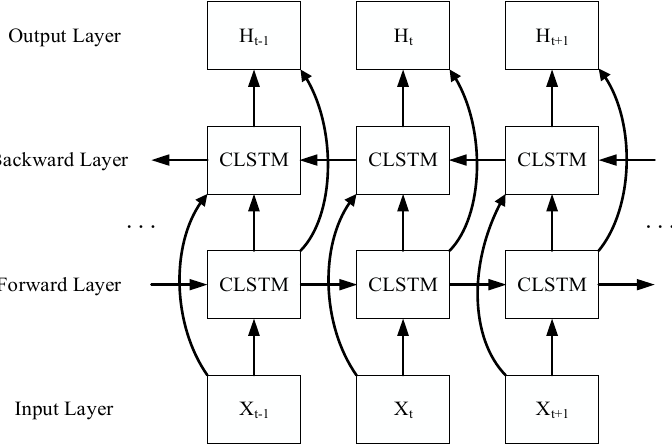
Figure 4. Structure diagram of bi-directional convolutional long short-term memory (LSTM).